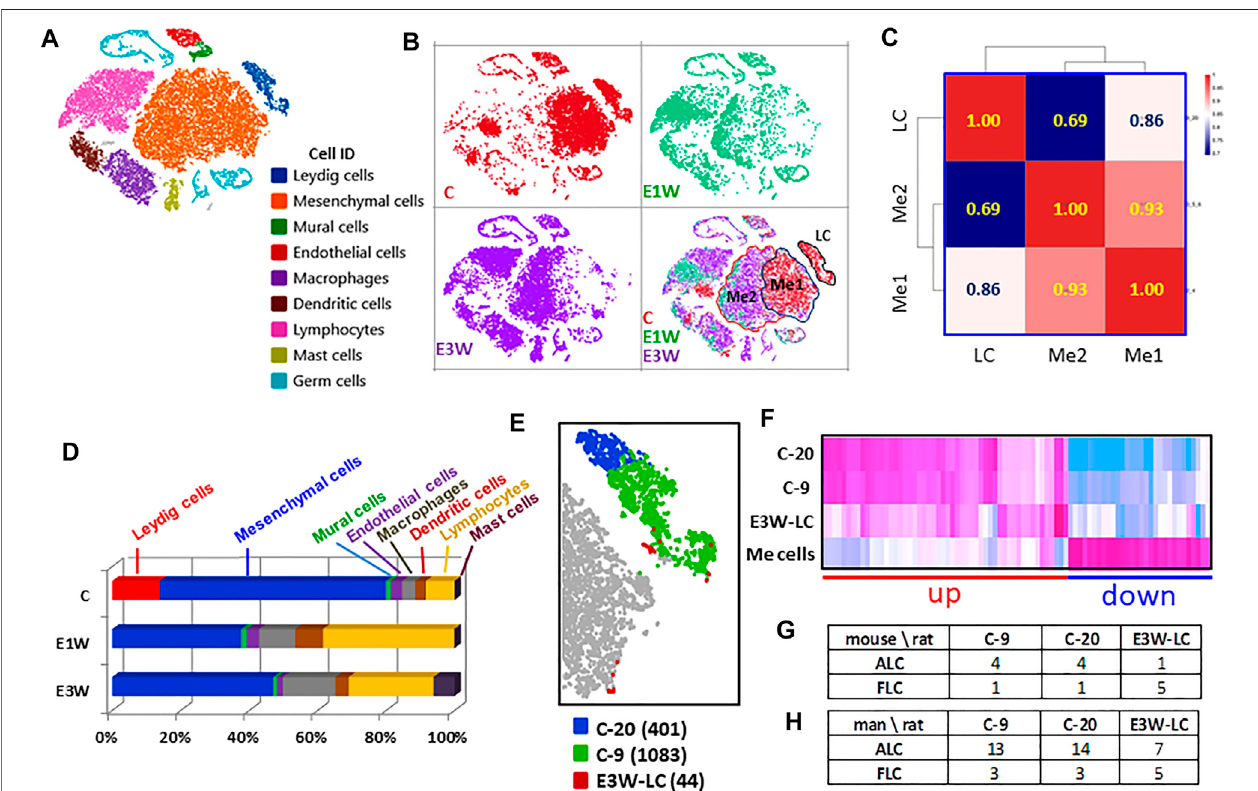
FIGURE3| EffectsofEDStreatmentonthemajorinterstitialcells. (A) Ninetesticularcellsidenti fi ed. (B) t-SNEdistributionsofthethreegroupsofcells. (C) Pearson correlationsamong mesenchymalsubcluster 1(Me1)and subcluster 2(Me2)and Leydig cell(LC). (D) Effect ofEDStreatmentoncellnumbers. (E) Three sub-clusters of Leydig cells, including cluster 20 (C-20, 401 cells), cluster 9 (C-9, 1,083 cells) of CON and newly formed Leydig cells of E3W (E3W-LC, 44 cells). (F) Heatmap of the 3 Leydigcellclustersandcombinedmesenchymalcluster(Me)cells. (G,H) NumberofDEGssharedbythreeLeydigcellclusterswithpublishedfetalandadultLeydig cell marker